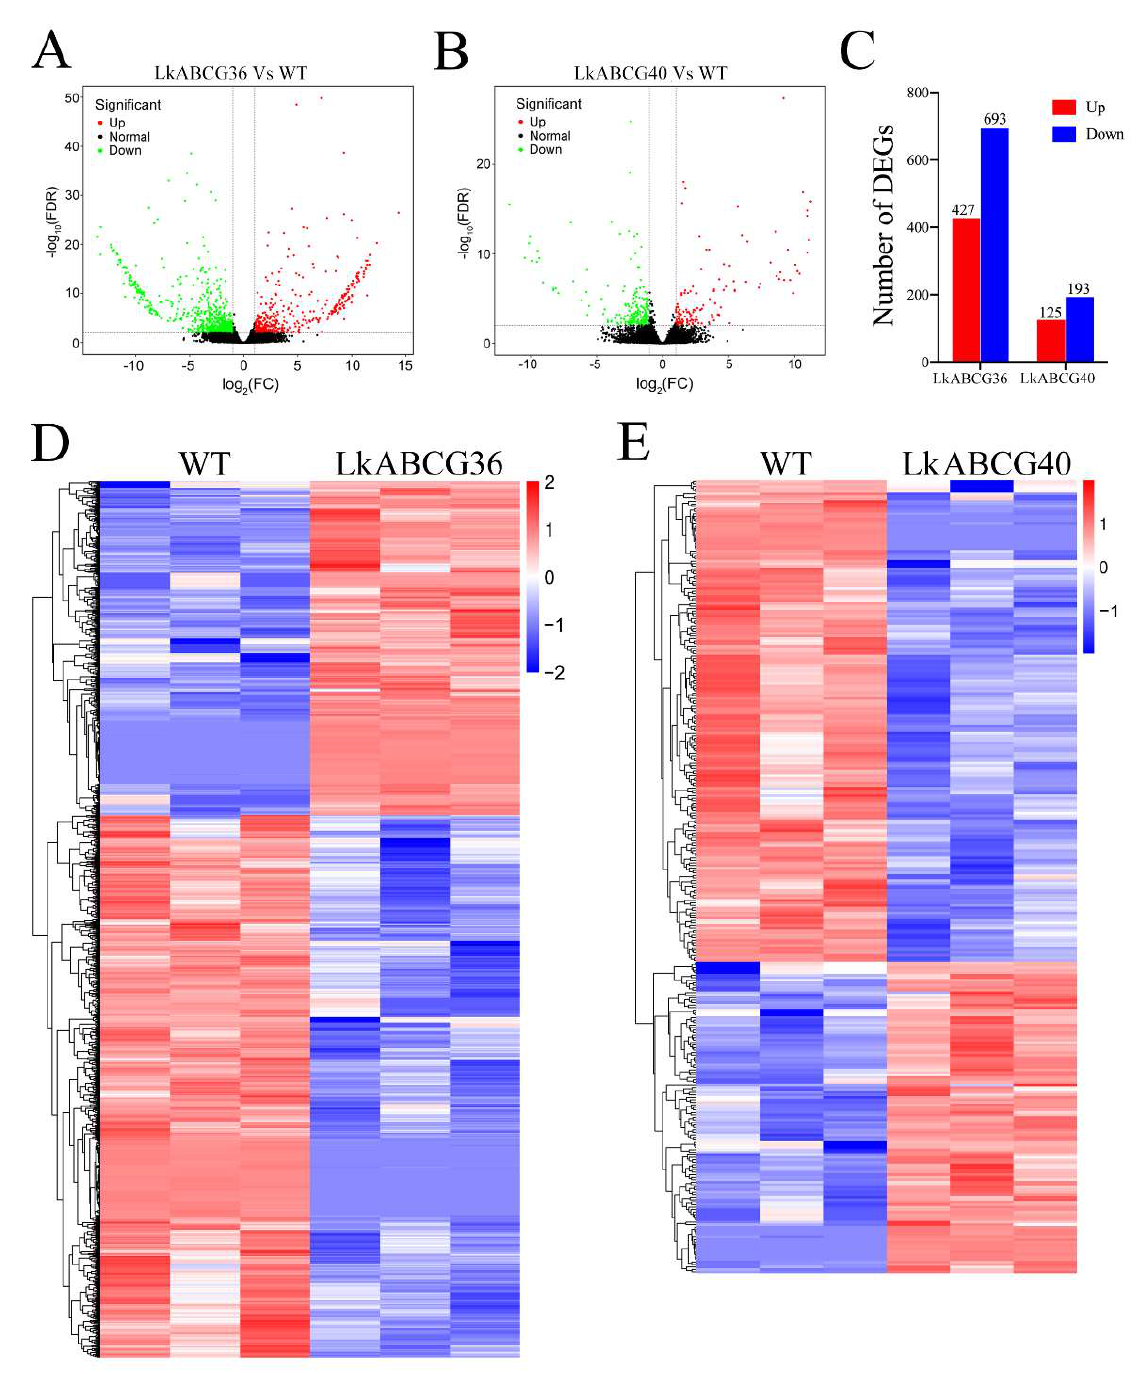
Figure 2. Transcript level profiles analysis of significantly differentially expressed genes. ( A , B ) Vol- cano plots of significantly differentially expressed genes (DEGs) between LkABCG36 ( A ) or LkABCG40 ( B ) and WT groups. DEGs were identified by comparing gene expression values with |log 2 (fold change)| ≥ 1 and p < 0.05. ( C ) Number of DEGs was counted. We found 427 and 693 significantly up- and downregulated genes, respectively, in LkABCG36 group compared with WT group. We found 125 and 193 significantly up- and downregulated genes, respectively, in LkABCG40 group compared with WT group. ( D , E ) Heatmap of DEGs between ABCG36 and WT groups ( D ), and between LkABCG40 and WT groups ( E ). FPKM values (transcript levels) were transformed to log 10 (FPKM) for color